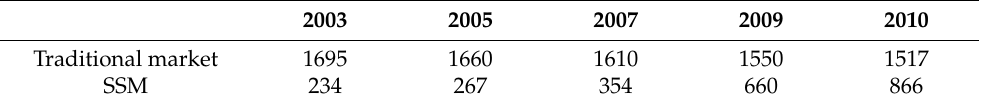
Figure 5. Food sales shares of large discount stores and e-commerce. Source: Retailon (2020) [41]. Table 1. Numbers for the super-supermarkets (SSM) and traditional